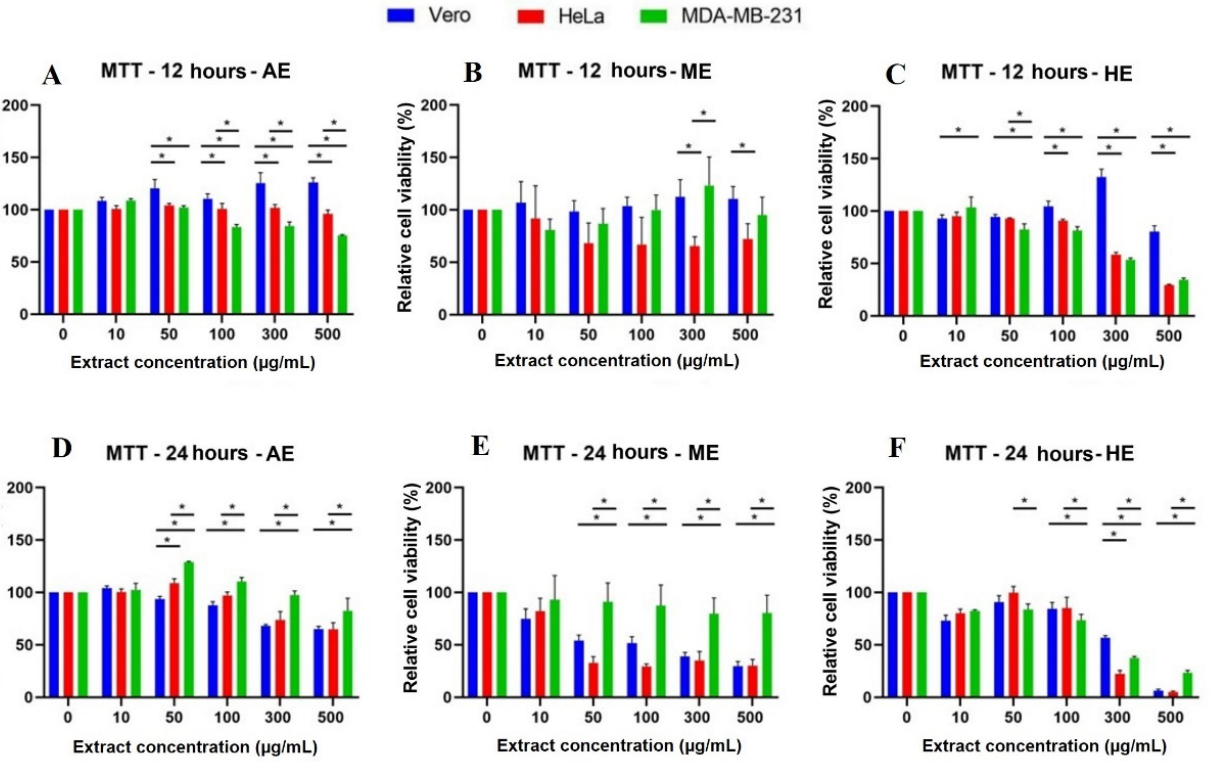
Figure 7. Cytotoxicity analysis by MTT assay in cells treated for 12 and 24 h with different concentrations of A. monostachya extracts. Relative cell viability percentages are shown for Vero, HeLa, and MDA-MB-231 lines. HeLa and MDA-MB-231 lines exposed to concentrations of 0, 10, 50, 50, 100, 300, and 500 µg/mL of AE ( A. monostachya ) are shown µg/mL of AE ( A , D ), ME ( B , E ), and HE ( C , F ). n = 8. * p < 0.05, Tukey’s multiple comparison test vs. Vero cells.